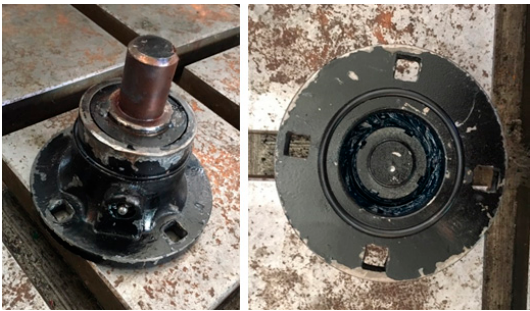
Figure 19. Appearance of hub bearing after test.